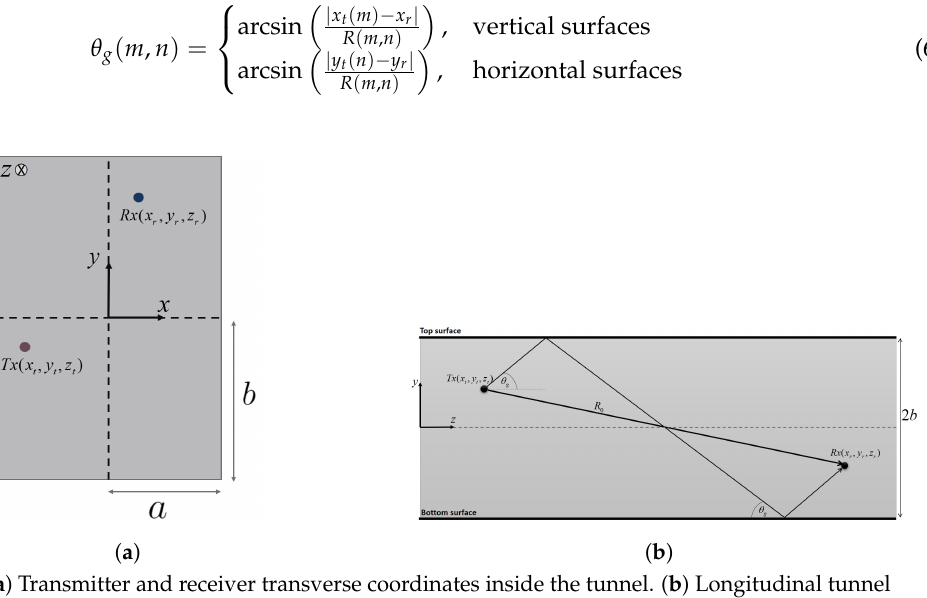
Figure 1. ( a ) Transmitter and receiver transverse coordinates inside the tunnel. ( b ) Longitudinal tunnel side view. Here, 2 a and 2 b are the width and height of the tunnel, respectively.